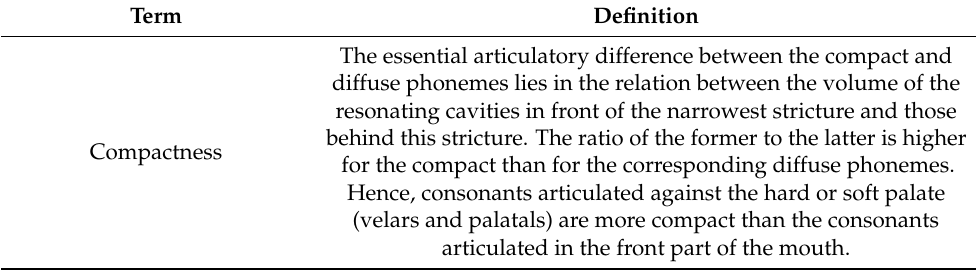
Table A3. Definitions of Distinctive Feature Categories a,b